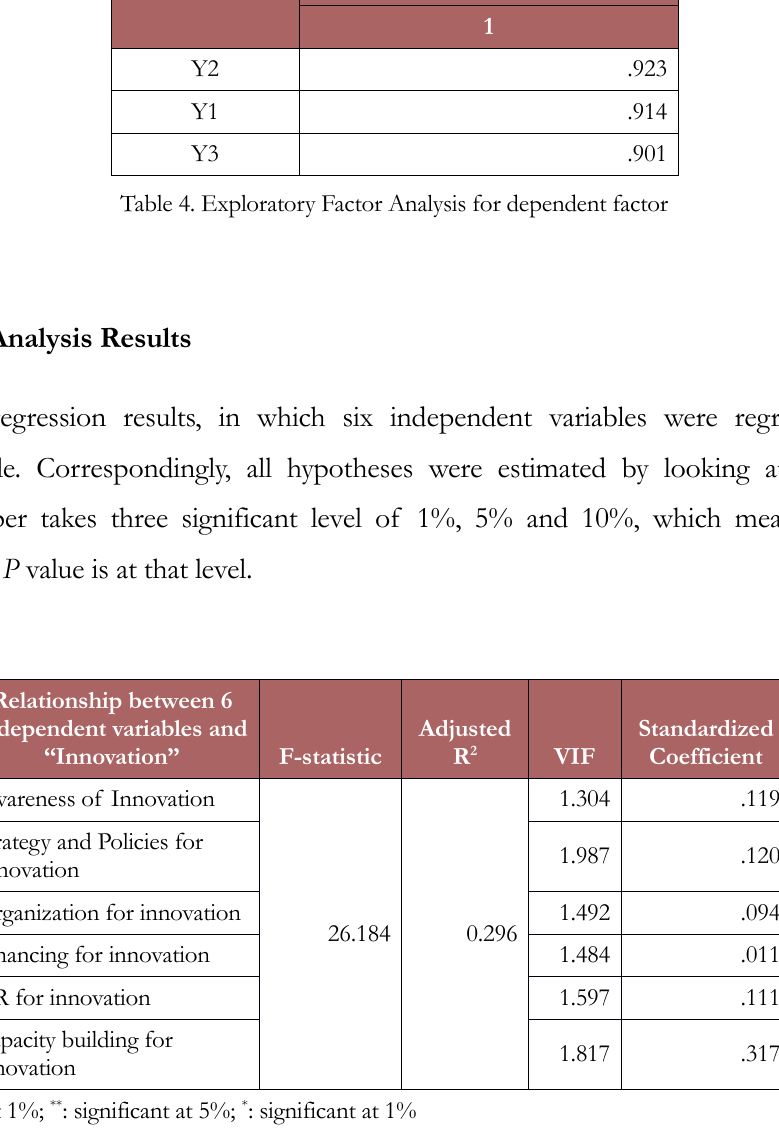
Table 5. Regression